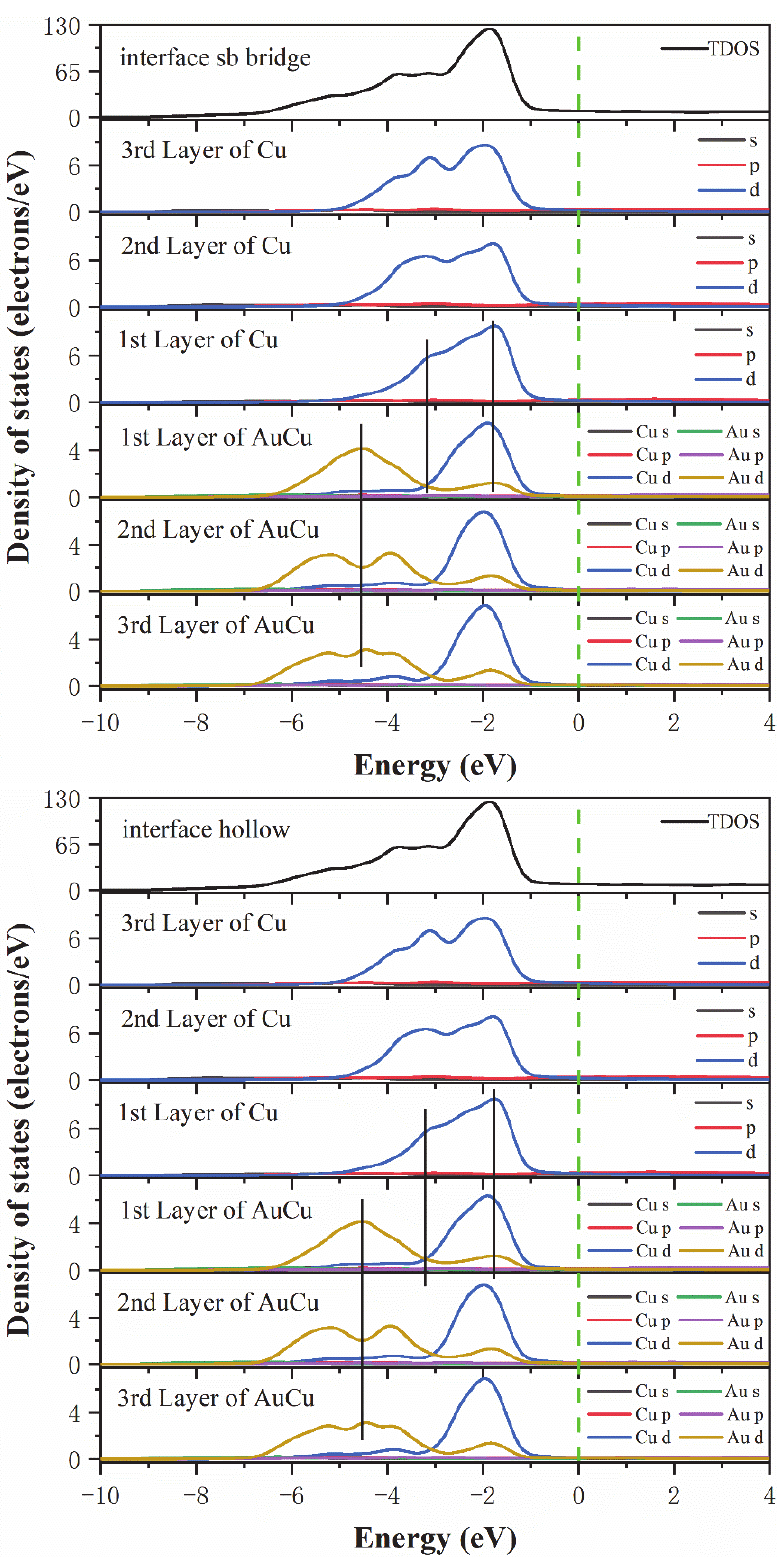
Figure 5. The total density of states and partial density of states of the Cu(200)/AuCu(200) interface. The vertical dashed line indicates the Fermi level and the vertical lines are drawn for guiding to the eye.